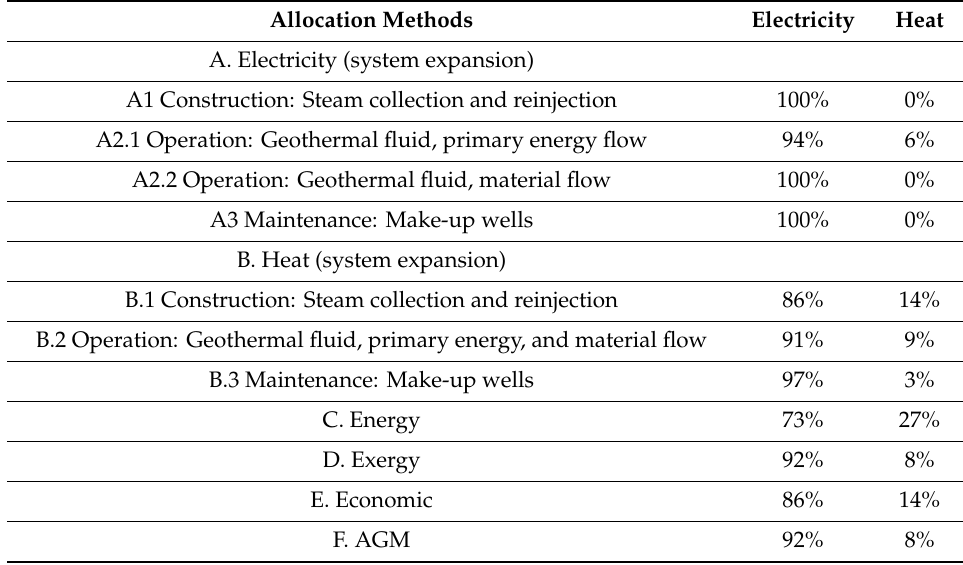
Table 2. Results for the allocation factors resulting from the different allocation methods A–F investigated in the study.